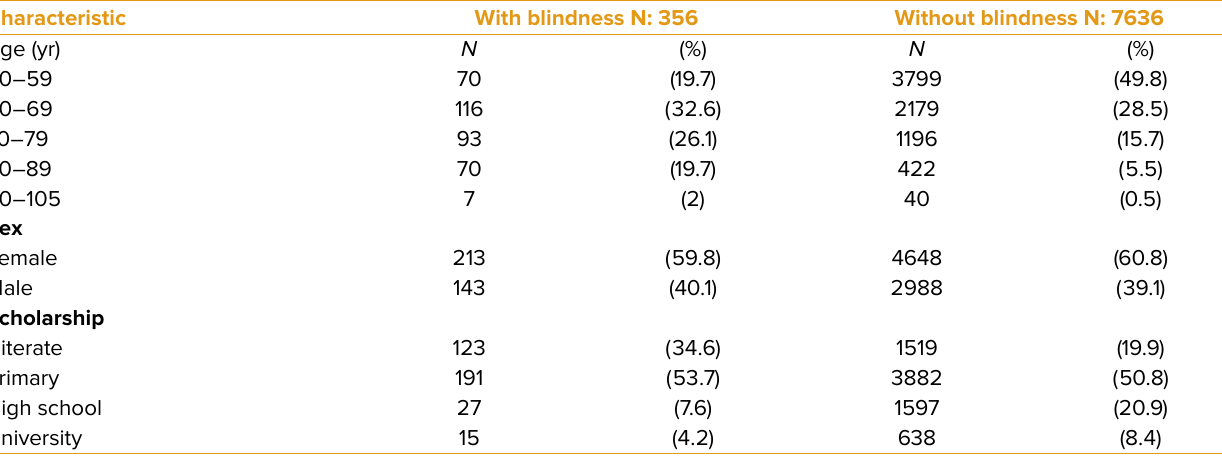
Table 3. Comparison of sociodemographic data of adults aged 50 years and over, with and without blindness in both eyes in